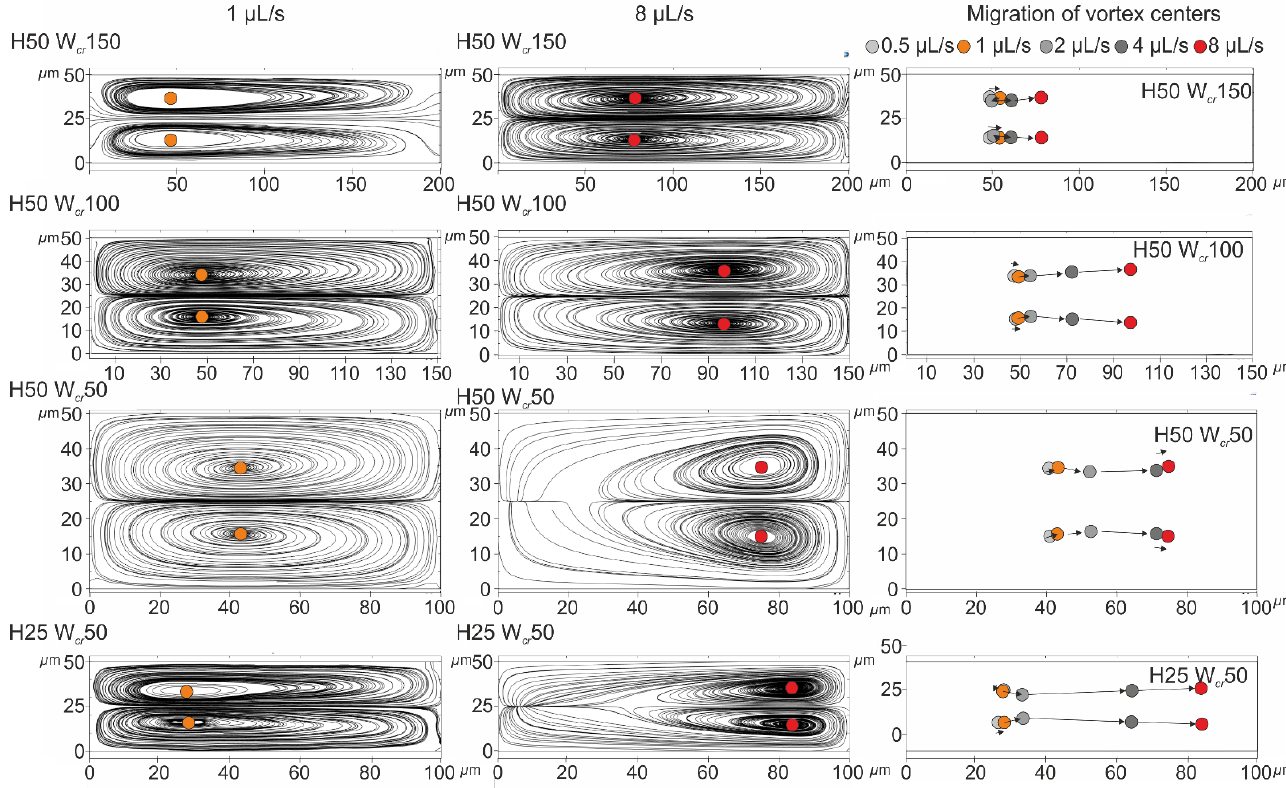
Figure 2. The lateral movement of the vortex’s center was followed in case of different channel parameters (H: 50 and 25 µm, W cr : 150, 100 and 50 µm) at 0.5, 1, 2, 4 and 8 µL/s flow rates. Velocity- field-based streamlines were visualized in the y-z plane of the channel cross-section at a smaller curvature (W cr + 50 µm) at 1 and 8 µL/s flow rates.